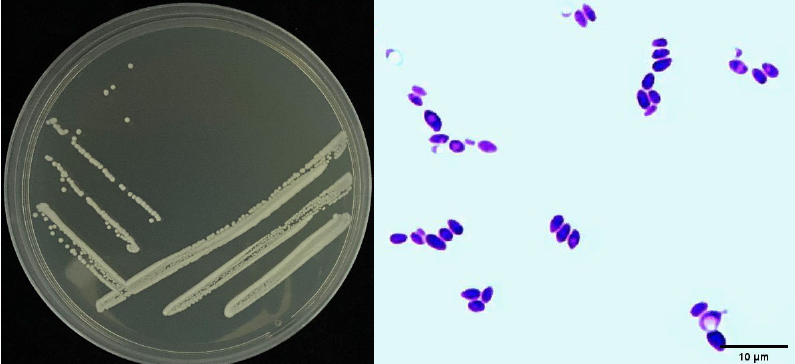
Figure 2. Morphological characteristics of bacteria isolate Sneb518. Left: The morphological charac- teristics of Sneb518 on NA plate. Right: Gram-positive staining of Sneb518.